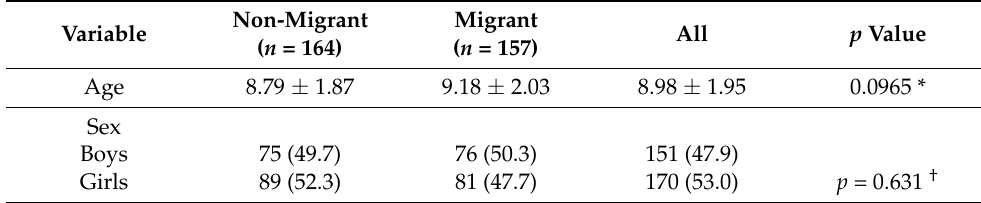
Table 1. Age and sex distribution of schoolchildren.